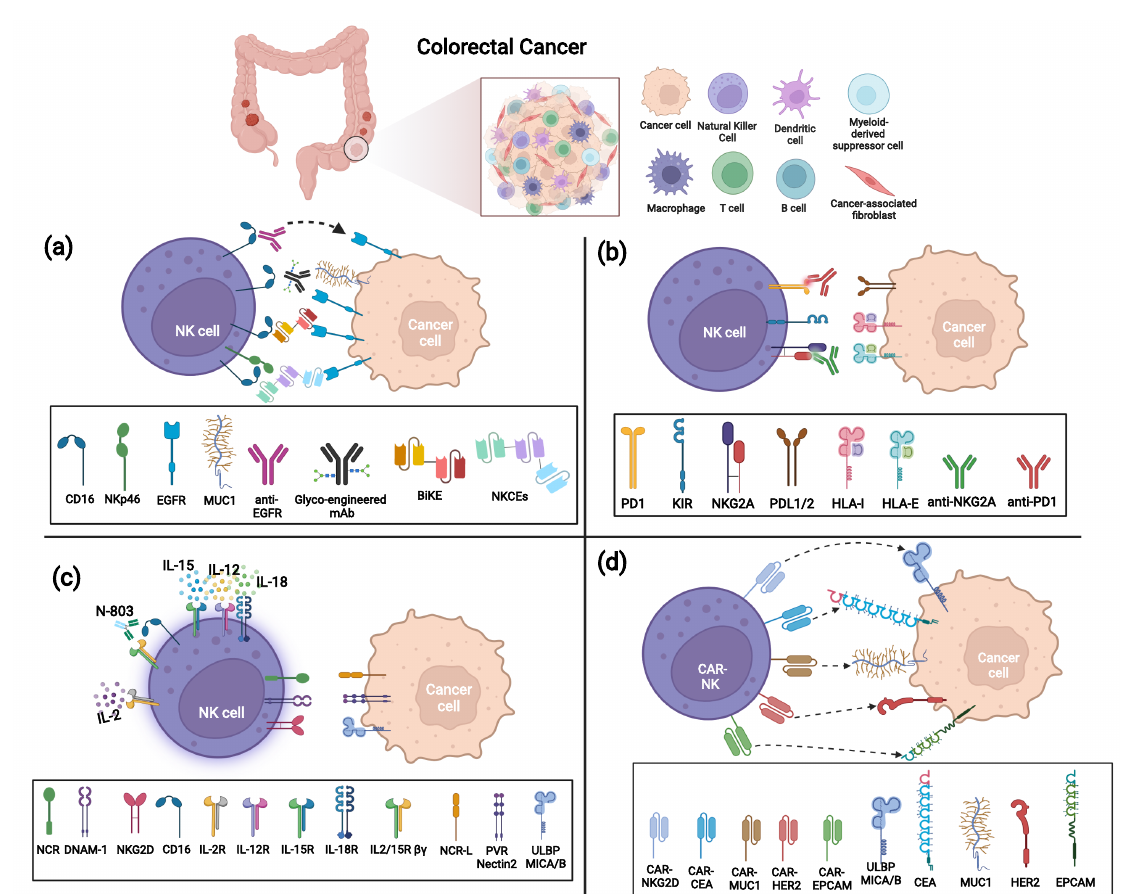
Figure 2. Strategies to enhance anti-tumor NK cell function against Colorectal Cancer (CRC). ( a ) ADCC triggering strategies via anti-TAA mAbs, BiKe, or NKCEs; ( b ) IC blockade via anti-NKG2A and anti-PD-1 mAbs; ( c ) Cytokine activation of NK cells by IL-2, IL-15/IL-12/IL-18 combination, or N-803; ( d ) CAR-modified NK cells targeting several TAAs (CEA, MUC-1, EpCAM, HER-2, and NKG2D ligands MICA/B and